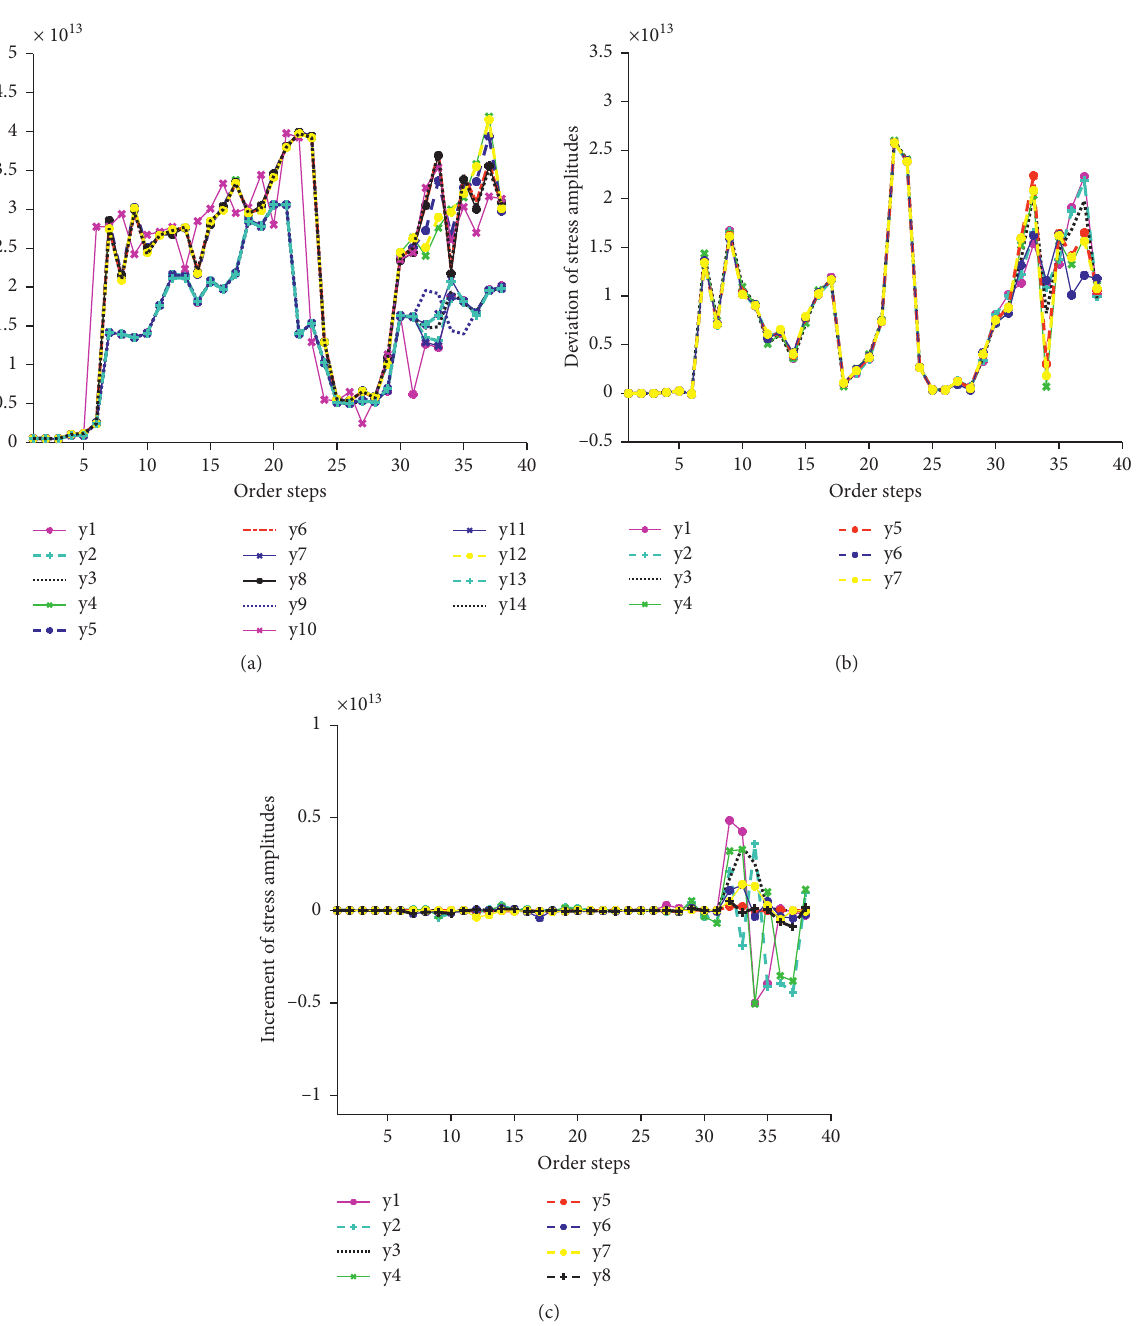
Figure 9: Stress amplitudes with centrifugal force and thermal load. (a) SAs. (b) Deviation of SAs. (c) Variable quantity of